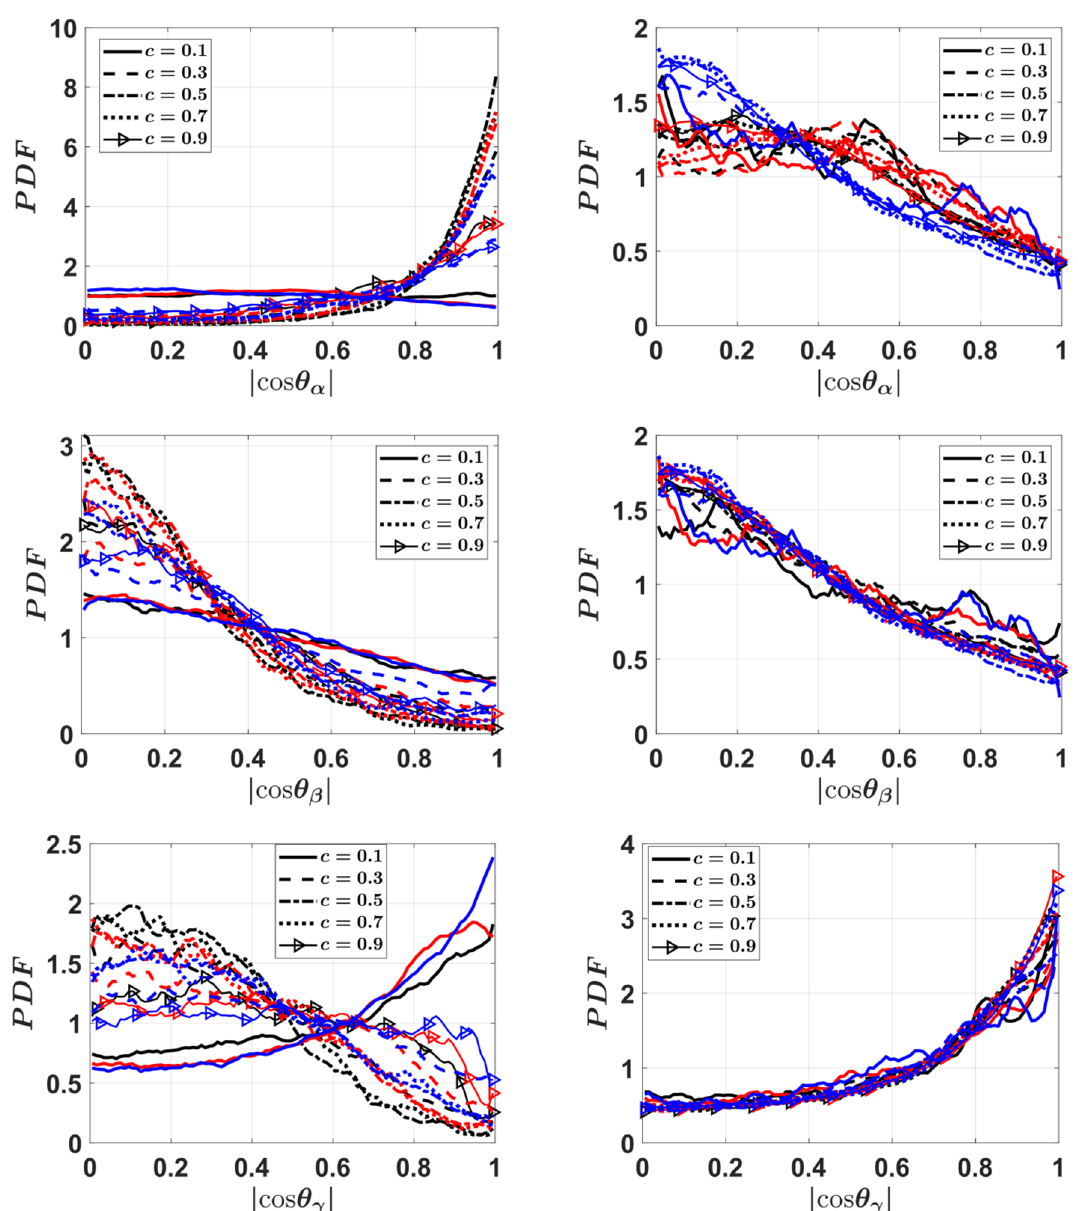
Figure 7. PDFs of |cosθ (cid:2961) |,(cid:3627)cos θ (cid:2962) (cid:3627) and (cid:3627)cos θ (cid:2963) (cid:3627) (1st–3rd row) for (cid:1855) = 0.1,0.3, 0.5,0.7,0.9 isolevels across the flame for u (cid:48) / S L = 4.0 (black) 6.0 (red) and 8.0 (blue) for statistically planar turbulent premixed flames (first column) and homogeneous MILD cases (second column).